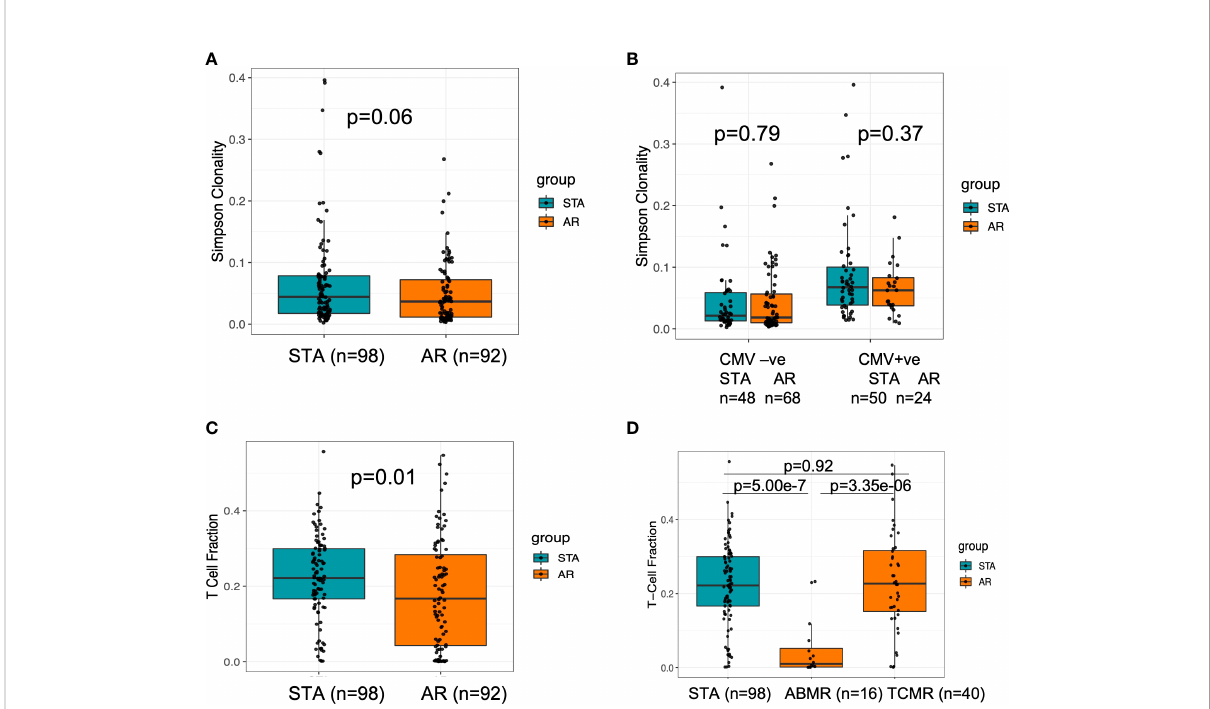
FIGURE 2 Baseline characteristics of TCR clonality and T cell fraction at baseline for transplant recipients who have future rejection and no rejection. (A) There was a trend towards higher clonality in stable subjects, which could indicate a more diverse repertoire at baseline in subjects who will experience acute rejection. (B) There was no difference in baseline repertoire clonality between the groups with or without CMV positivity. (C) When assessed the baseline T cell fraction in stable compared to acute rejection subjects, subjects with lower T cell fractions at baseline are at increased risk of rejection (p=0.01). (D) When we analyzed for T-cell fraction among clean TCMR and ABMR cases, we observed a signi fi cant difference between the two types of rejection cohorts (Kruskal Wallis p=4.03e-06) with a lower value in ABMR relative to TCMR using a post- hoc Dunn test p=3.35e-6.